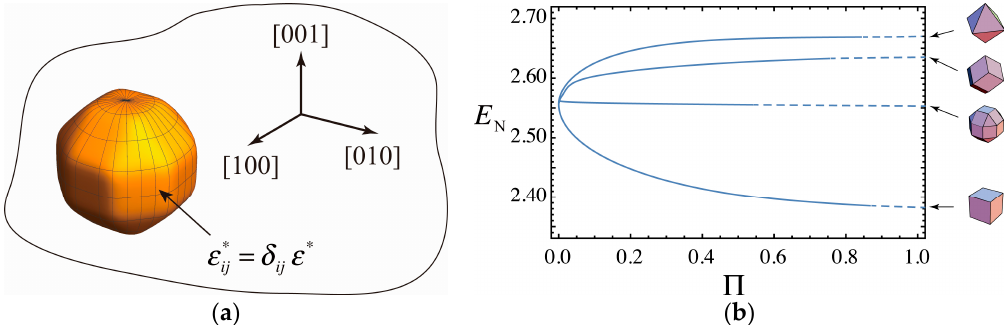
Figure 7. ( a ) Schematic illustration showing a superspherical coherent precipitate in a matrix with a cubic structure. The precipitate has a purely dilatational misfit strains ε strains in the material containing the precipitate. ( b ) The precipitate-shape dependence of the elastic-strain energy shown by the relationship between the normalized elastic-strain energy E and the polyhedrality Π . The results for the precipitate shapes of the hexahedral, octhedral, dodecahedral and RCO superspheres are